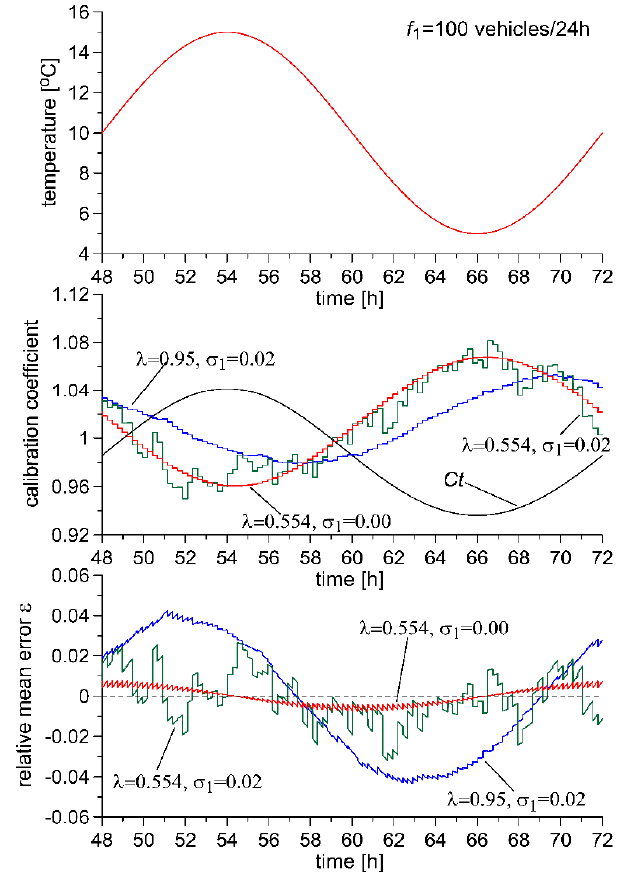
Figure 5. Time variability in vehicle weighing error for two different values of the forgetting factor